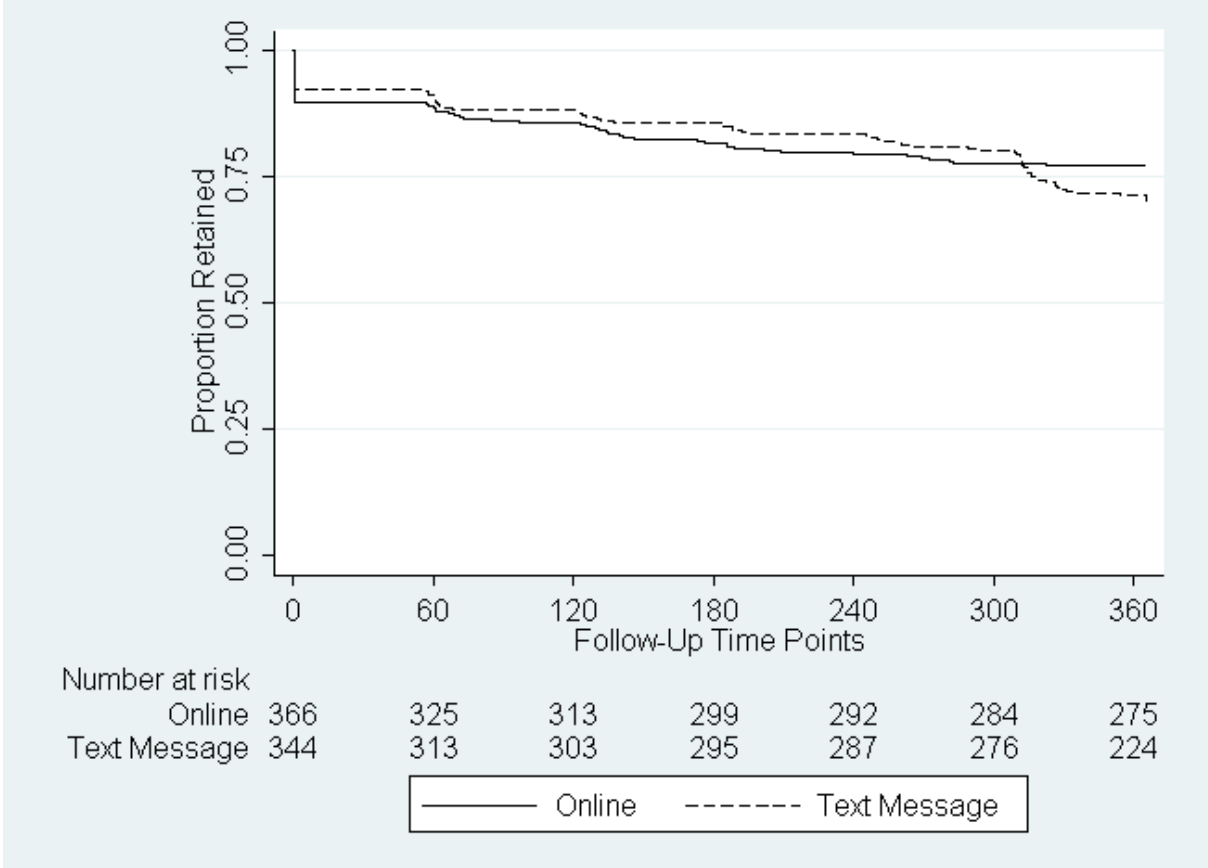
Figure 2. Retention of participants in an online study, by randomization arm (N=710).